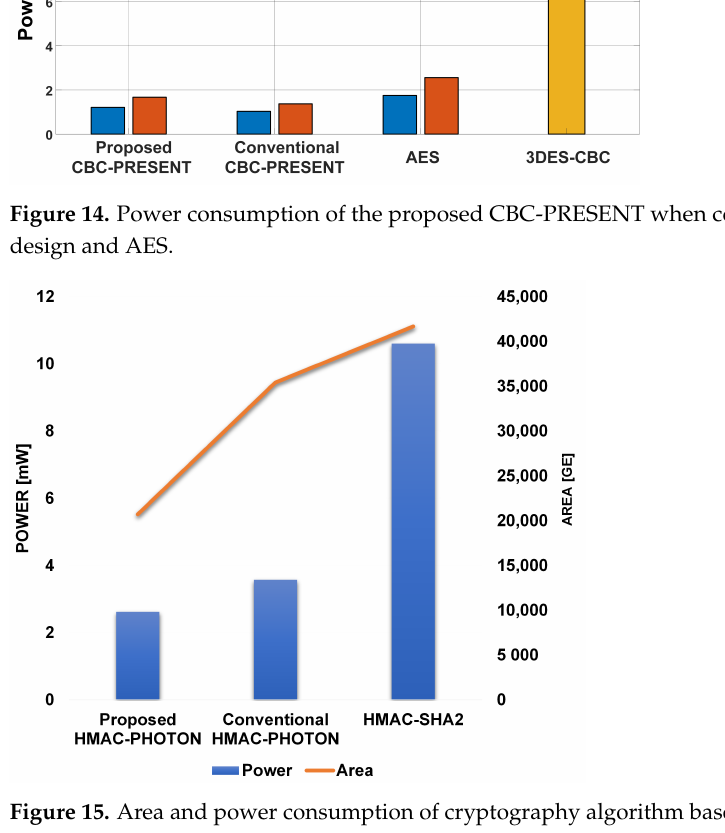
Figure 15. Area and power consumption of cryptography algorithm base